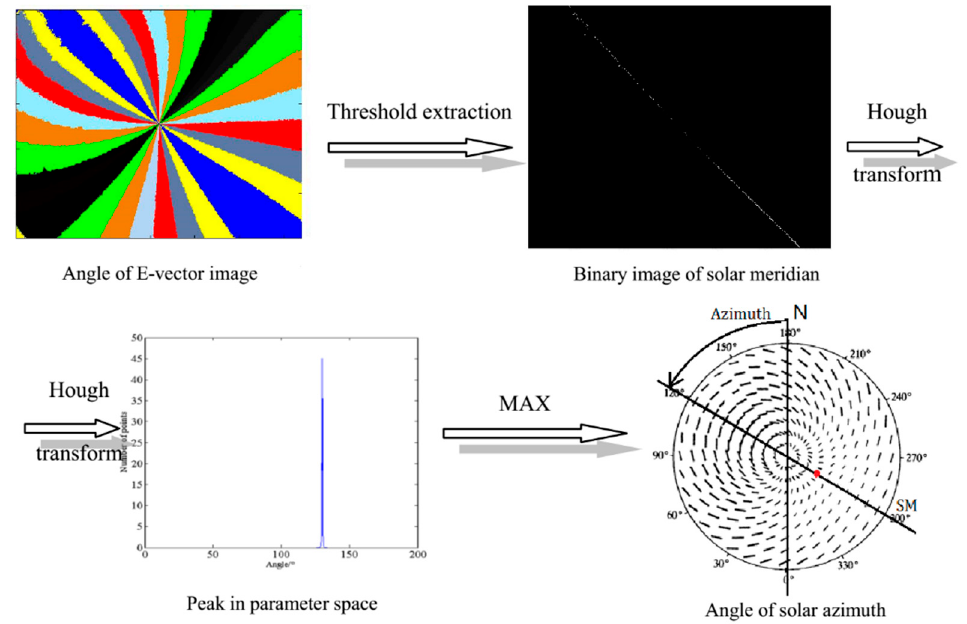
Figure 5. The flowchart of the orientation algorithm.